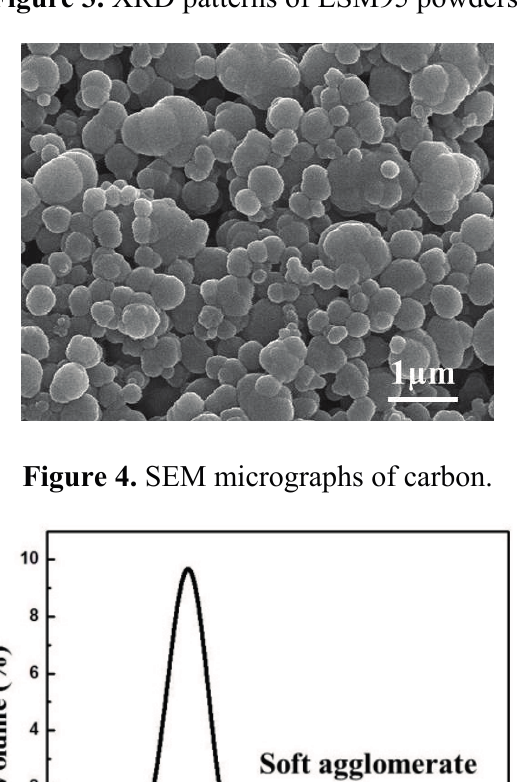
Figure 3. XRD patterns of LSM95 powders.